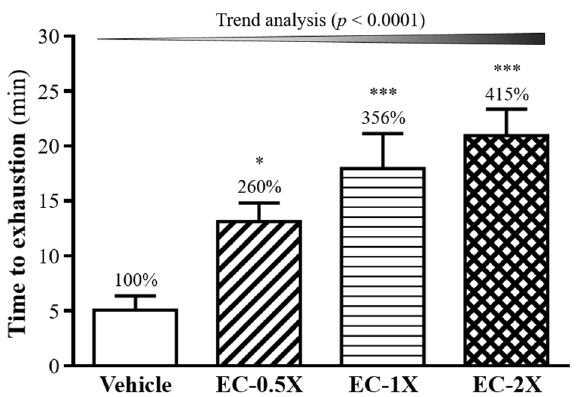
Figure 1. Effect of a four-week EC supplementation on endurance swimming performance in mice. Mice were pretreated with the vehicle, EC-0.5X, EC-1X, and EC-2X for 28 days. Data are expressed as mean ± SEM ( n = 10). Numbers indicate percentage (%) change with vehicle group fixed at 100%. Significant difference from control group according to one-way ANOVA is indicated * p < 0.05, *** p < 0.001.